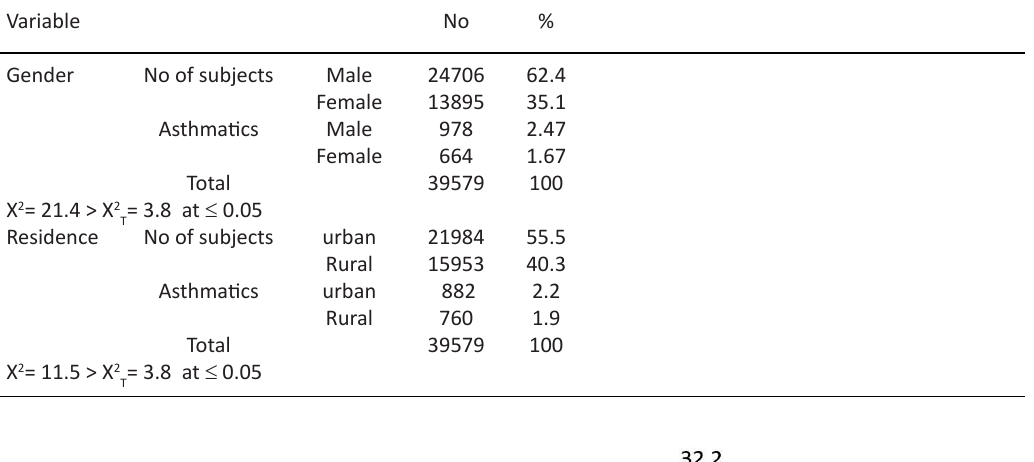
Table 2. Demographic characteristics of patients having asthma Variable